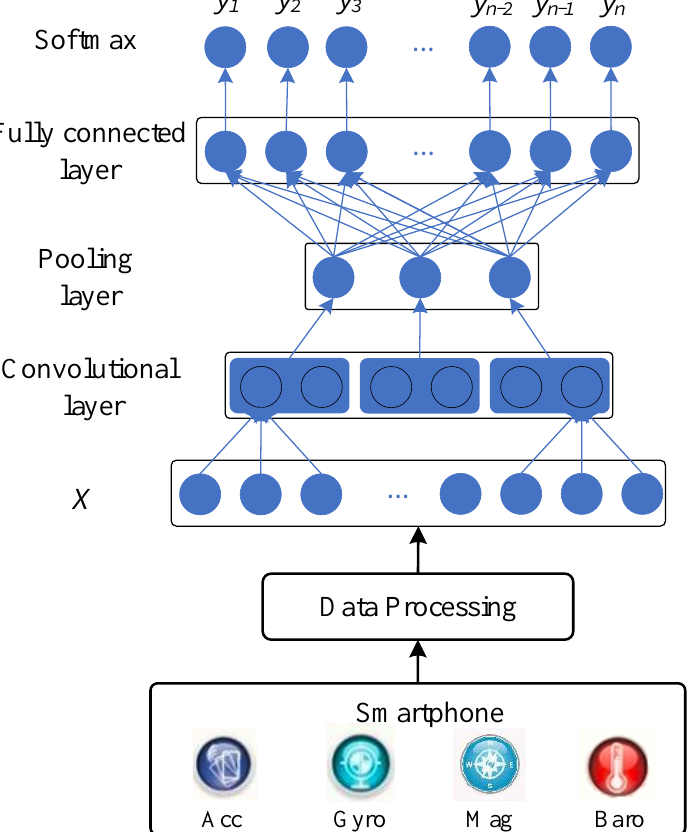
Figure 1. The architecture of the proposed